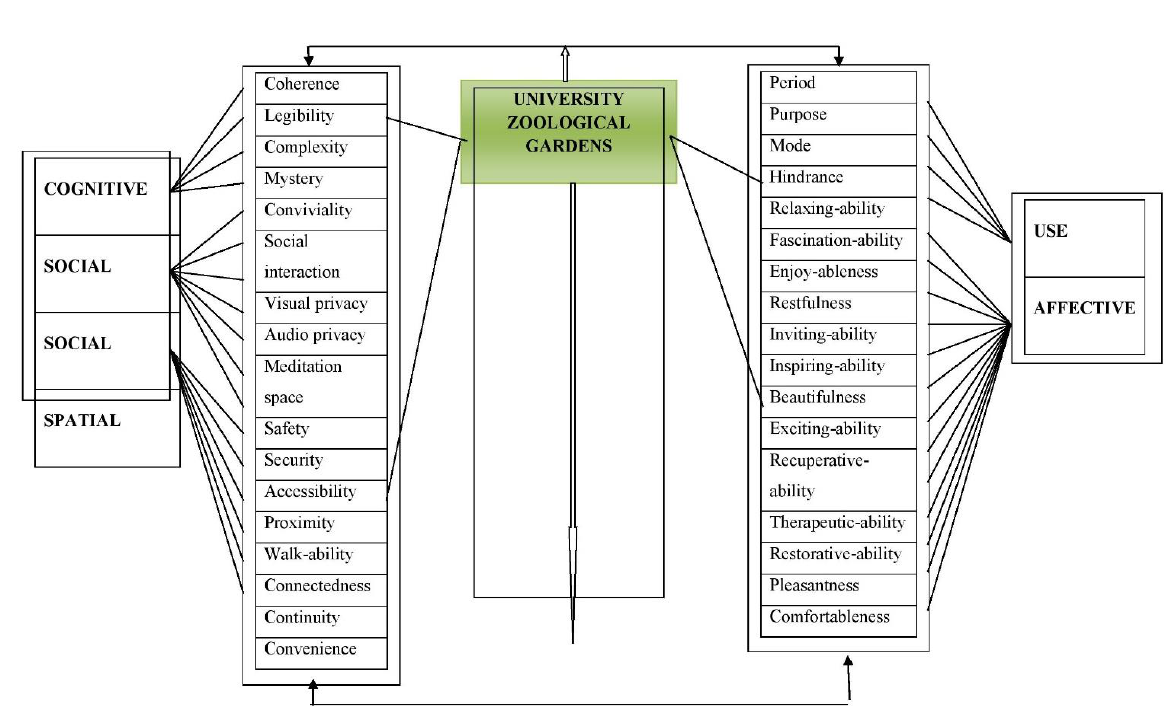
Figure 8. EBD framework for